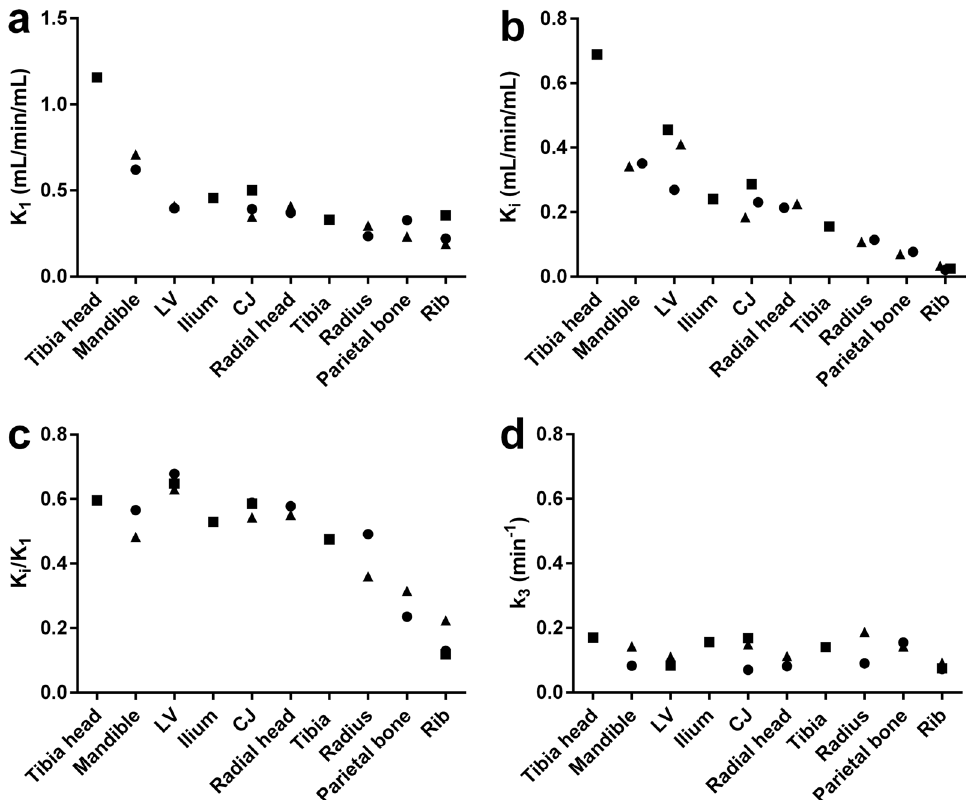
Fig. 3 Individual kinetic values derived from a model of [ 18 F]fluoride uptake for different rat bones. a K 1 : describes bone perfusion; b K i : reflects bone osteoblastic activity; c K i /K 1 : describes the efficiency of unidirectional extraction from blood to bone; and d k 3 : the rate constant from the extravascular compartment to the bone bound compartment. Values are based on measurements in 1–3 male rats. Different symbols represent different rats. LV lumbar vertebrae, CJ costochondral joint = =